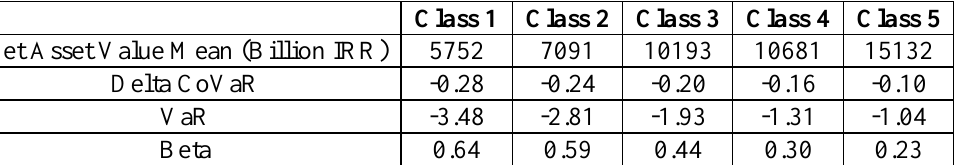
Table 7. Mean Parameters of Funds in the